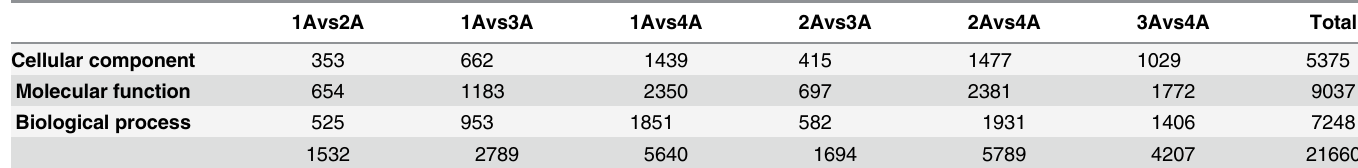
Table 2. Gene ontology (GO) Molecular function, Cellular component and Biological process among the leaf developmental stages.